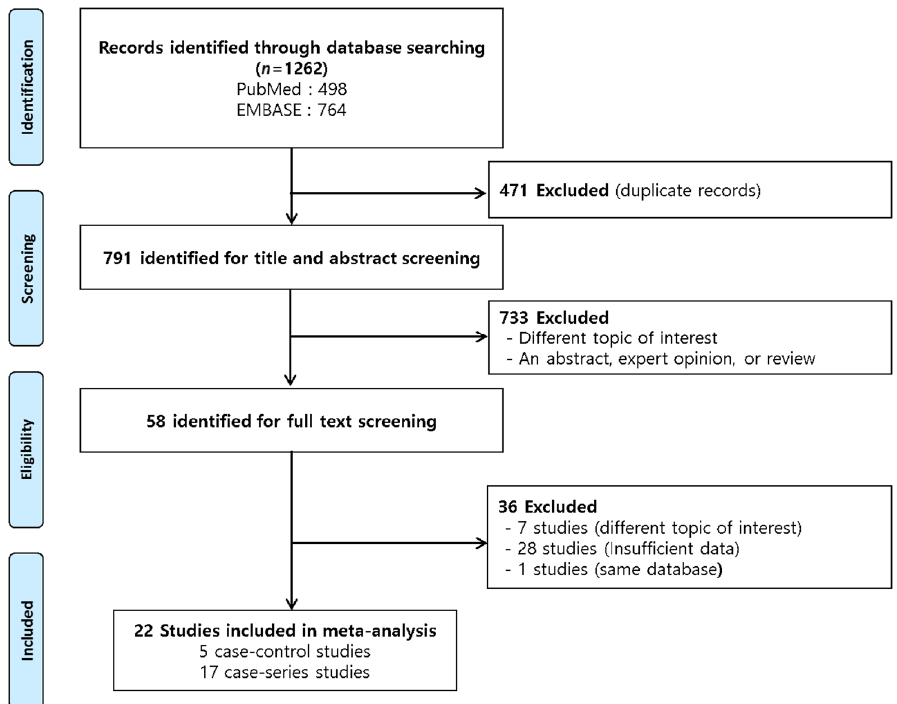
Figure 1. Scheme of the search strategy. Table 1. Study characteristics of the included studies.